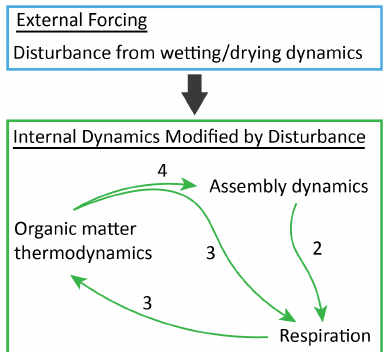
Figure 6. Integrated conceptual interpretation of results from this study. Collectively, our results indicate that the external forcing im- posed by disturbance leads to feedback between assembly of the putatively active community and respiration rates that is modulated by coupled dynamics in organic matter thermodynamics. Relative to Fig. 1, here external and internal aspects of the environment are separated. The arrows within the internal dynamics component are analogous to arrows 2, 3, and 4 in Fig. 1. The arrow from external to internal is not considered in Fig. 1 and represents the impact of external forcing on all aspects of the internal system. These impacts are both direct effects of disturbance and indirect effects mediated through the internal feedback that collectively lead to impacts of re-wetting that are contingent on desiccation